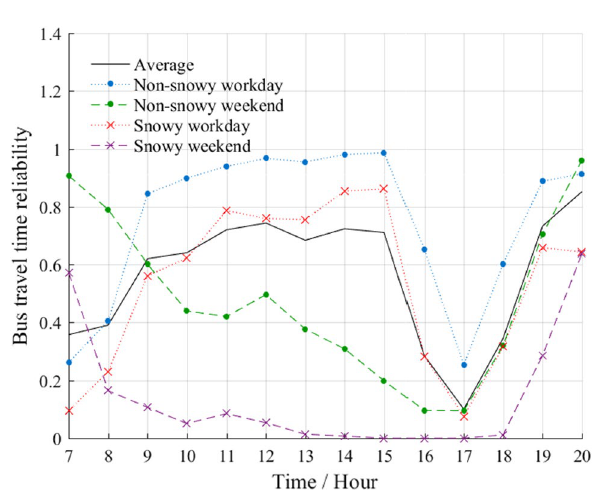
Fig. 5 Bus travel time reliability in different weather and day of